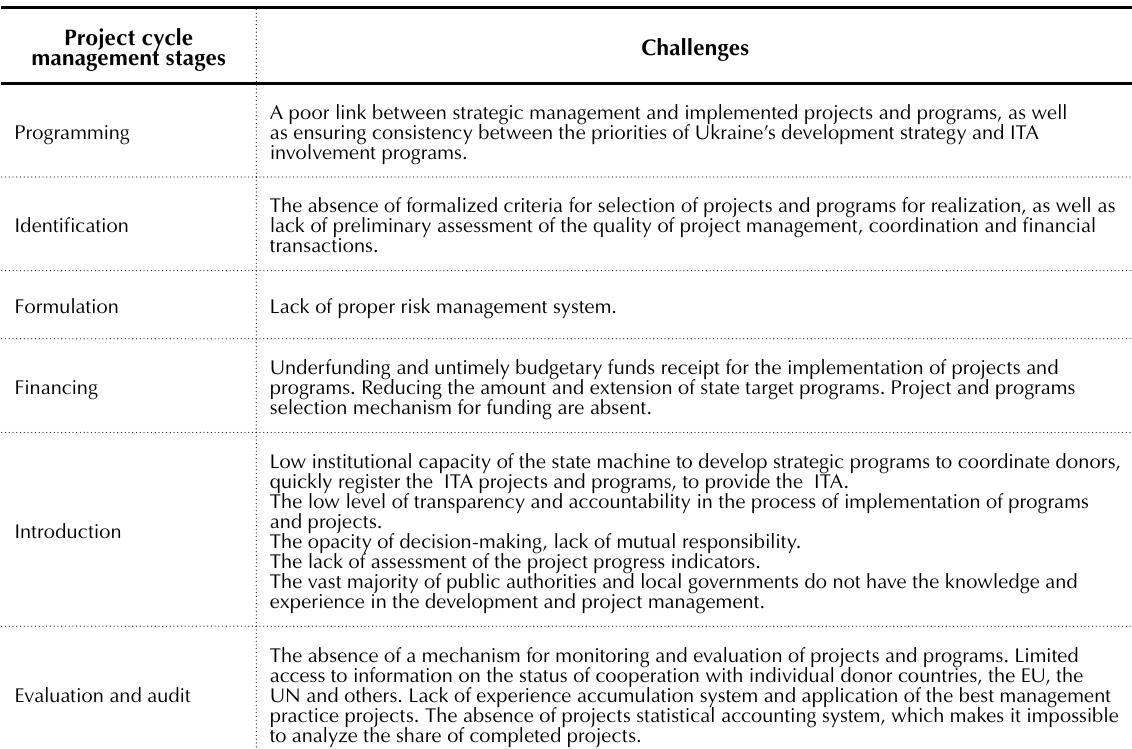
Table 2. Challenges in implementa�on of public projects and programs in Ukraine